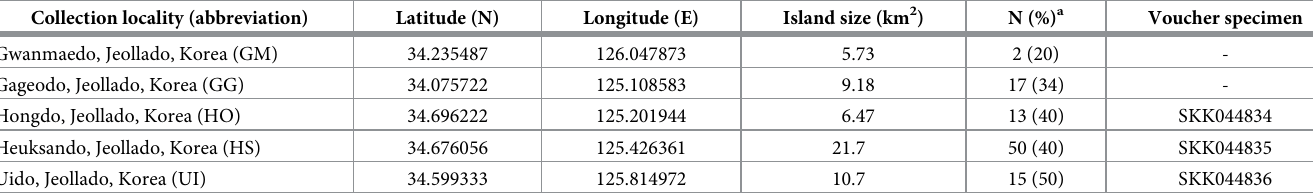
Table 1. Locality and voucher information of five Saussurea polylepis populations used in this